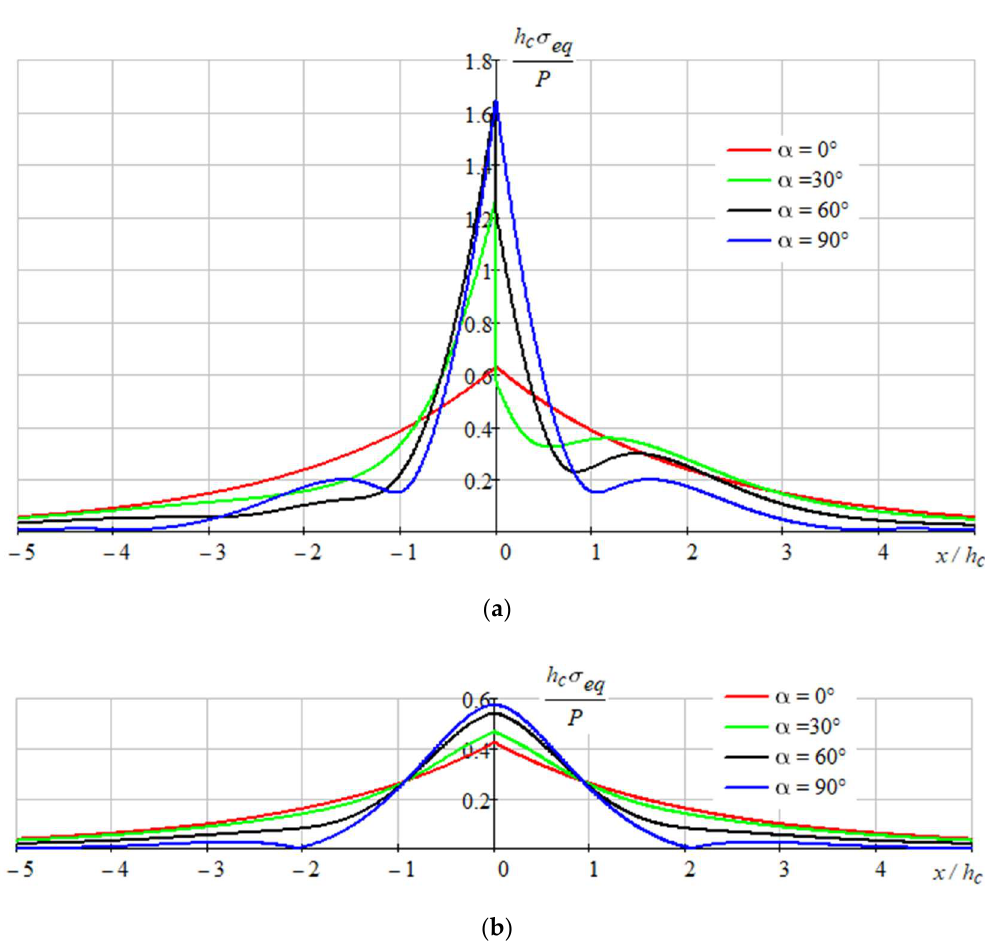
Figure 10. Distribution of stresses: ( a ) — y